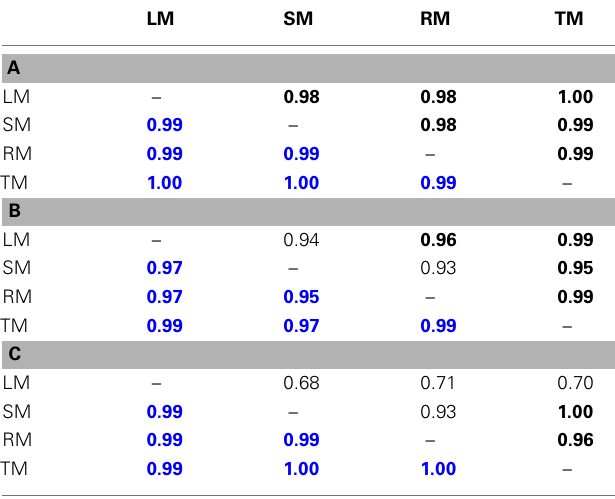
Table 1 | Correlation coefficients among leaf (LM), stem (SM), root (RM), and total plant mass (TM), both given before (black) and after (blue)